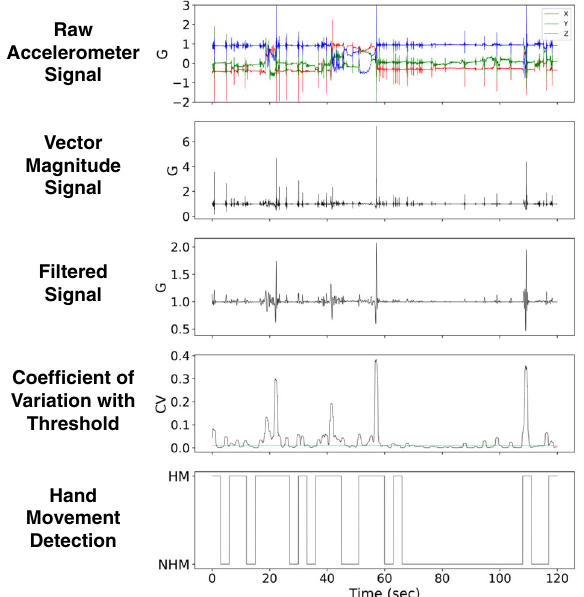
Fig. 9 Method for detecting hand movement from raw accel- erometer data. Vector magnitude derived from raw triaxial accelerometer data is fi ltered to remove high frequency compo- nents. An empirically derived threshold is then applied to coef fi cient of variation of the fi ltered signal to detect hand movement. HM, hand movement; NHM, no hand